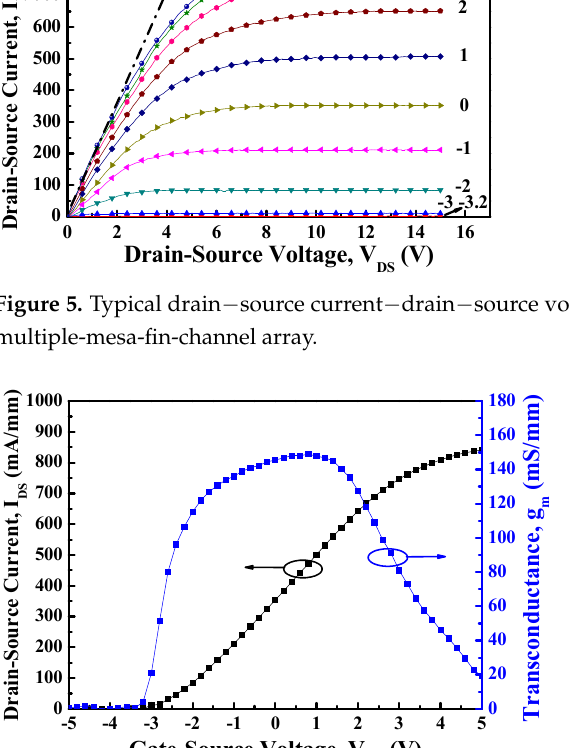
Figure 7. Short-circuit current gain and maximum available power gain as a function of frequency of MOSHEMTs with multiple-mesa-fin-channel array. 1